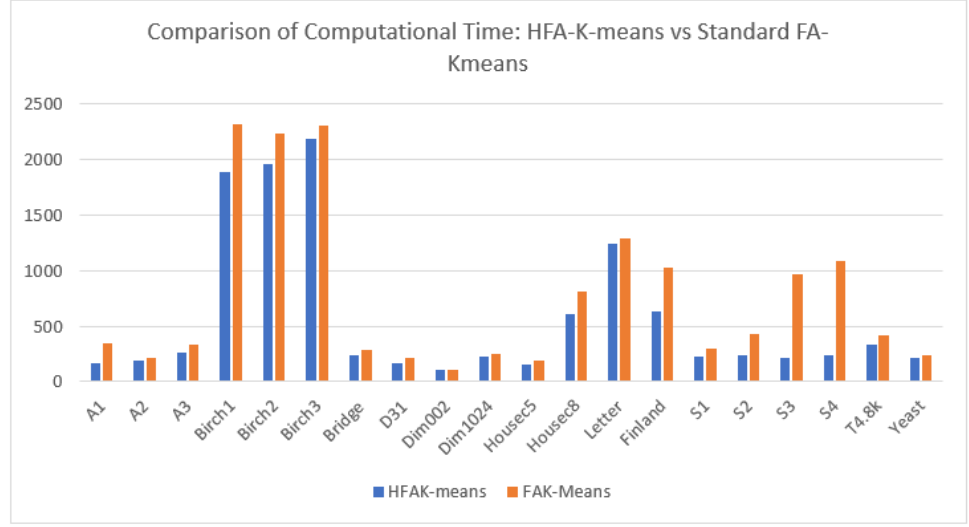
Figure 3. Mean execution run time of HFA-K-means and standard FA-K-means on DBI for 20 high- dimensional datasets over 20 runs. Table 5. Computation result for Improved FA-K-means on twenty high-dimensional datasets. High-Dimensional Datasets